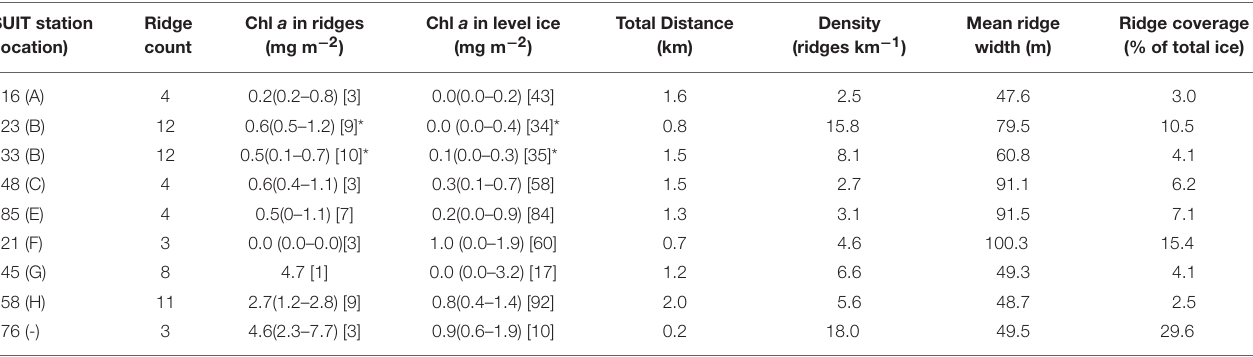
TABLE 5 | Summary of ridge identification analysis from the SUIT hauls conducted during PS80. SUIT station